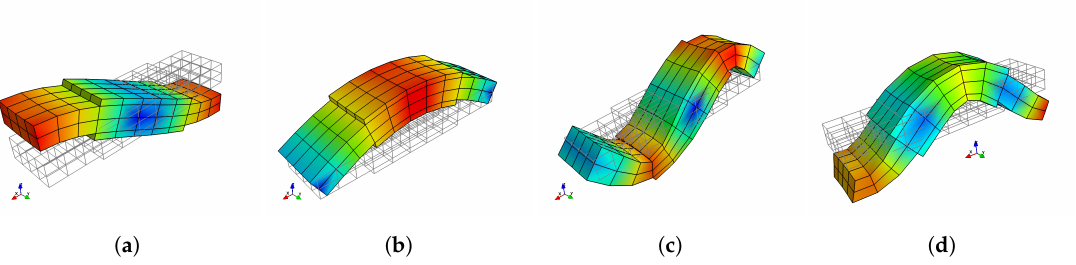
Figure 7. Waveshape of wave 0 of unit cell A at the border frequencies of the band gaps: ( a ) 11.634kHz, low WEMCF; ( b ) 12.556kHz, high WEMCF; ( c ) 46.475kHz, low WEMCF; ( d ) 50.077kHz, high